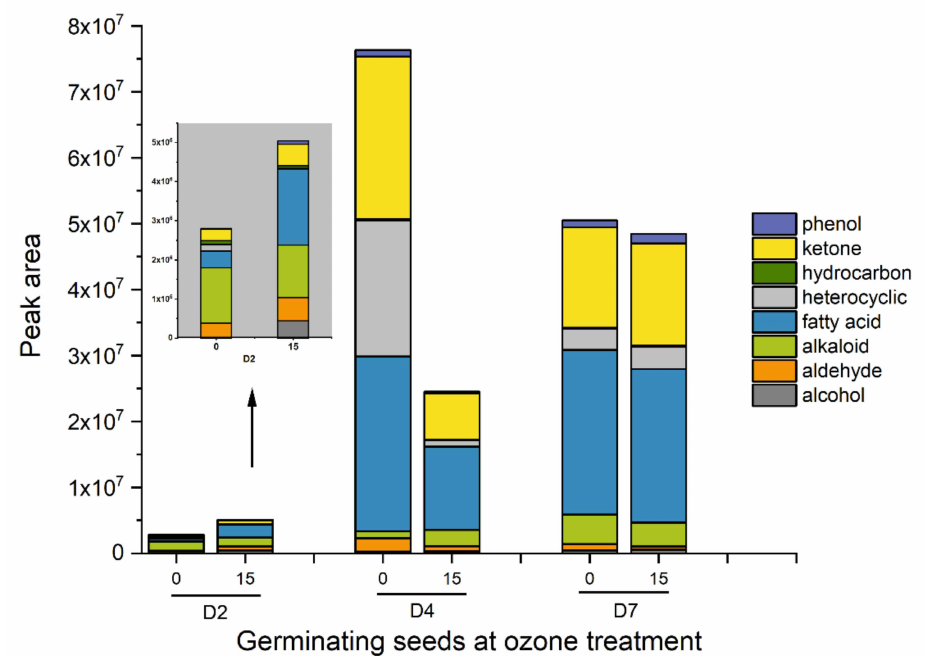
Figure 5. Volatile compound composition of germinating seeds (2, 4, and 7 days during germination) at ozone (0 and 15 min) treatment. The compounds of three replications were analyzed using solid-phase microextraction (SPME) and liquid absorption